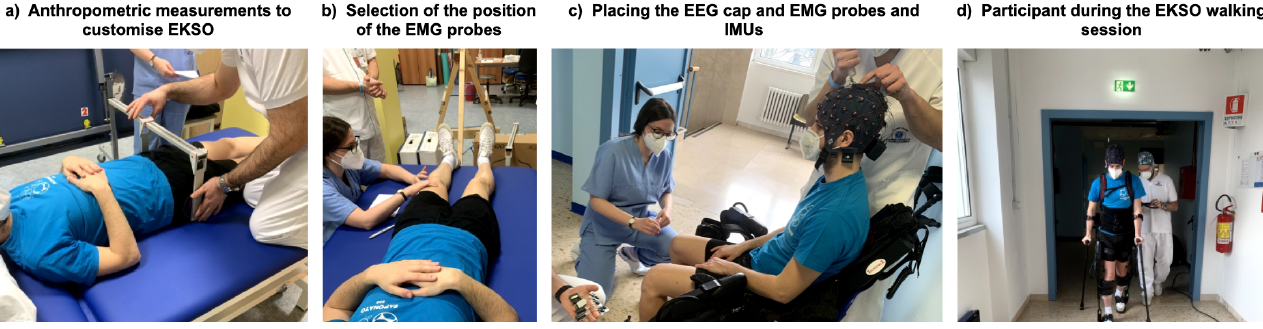
Figure 1. Participant preparation: ( a ) anthropometric measurements for EKSO customisation; ( b ) minimal crosstalk area recognition for EMG sensors placement; ( c ) EEG cap, EMG electrodes and probes and IMUs placement; ( d ) example of EKSO